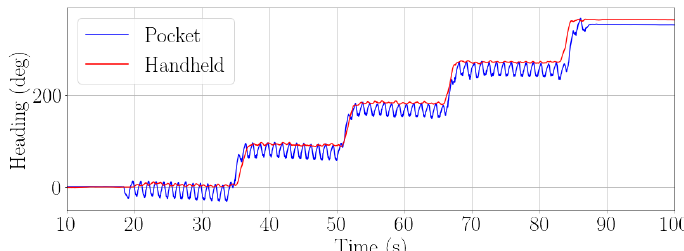
Figure 19. Estimation of heading in a square-like trajectory for two smartphone carrying modes: pocket (blue) and handheld (red). The walk has been recorded by using simultaneously two smartphones.